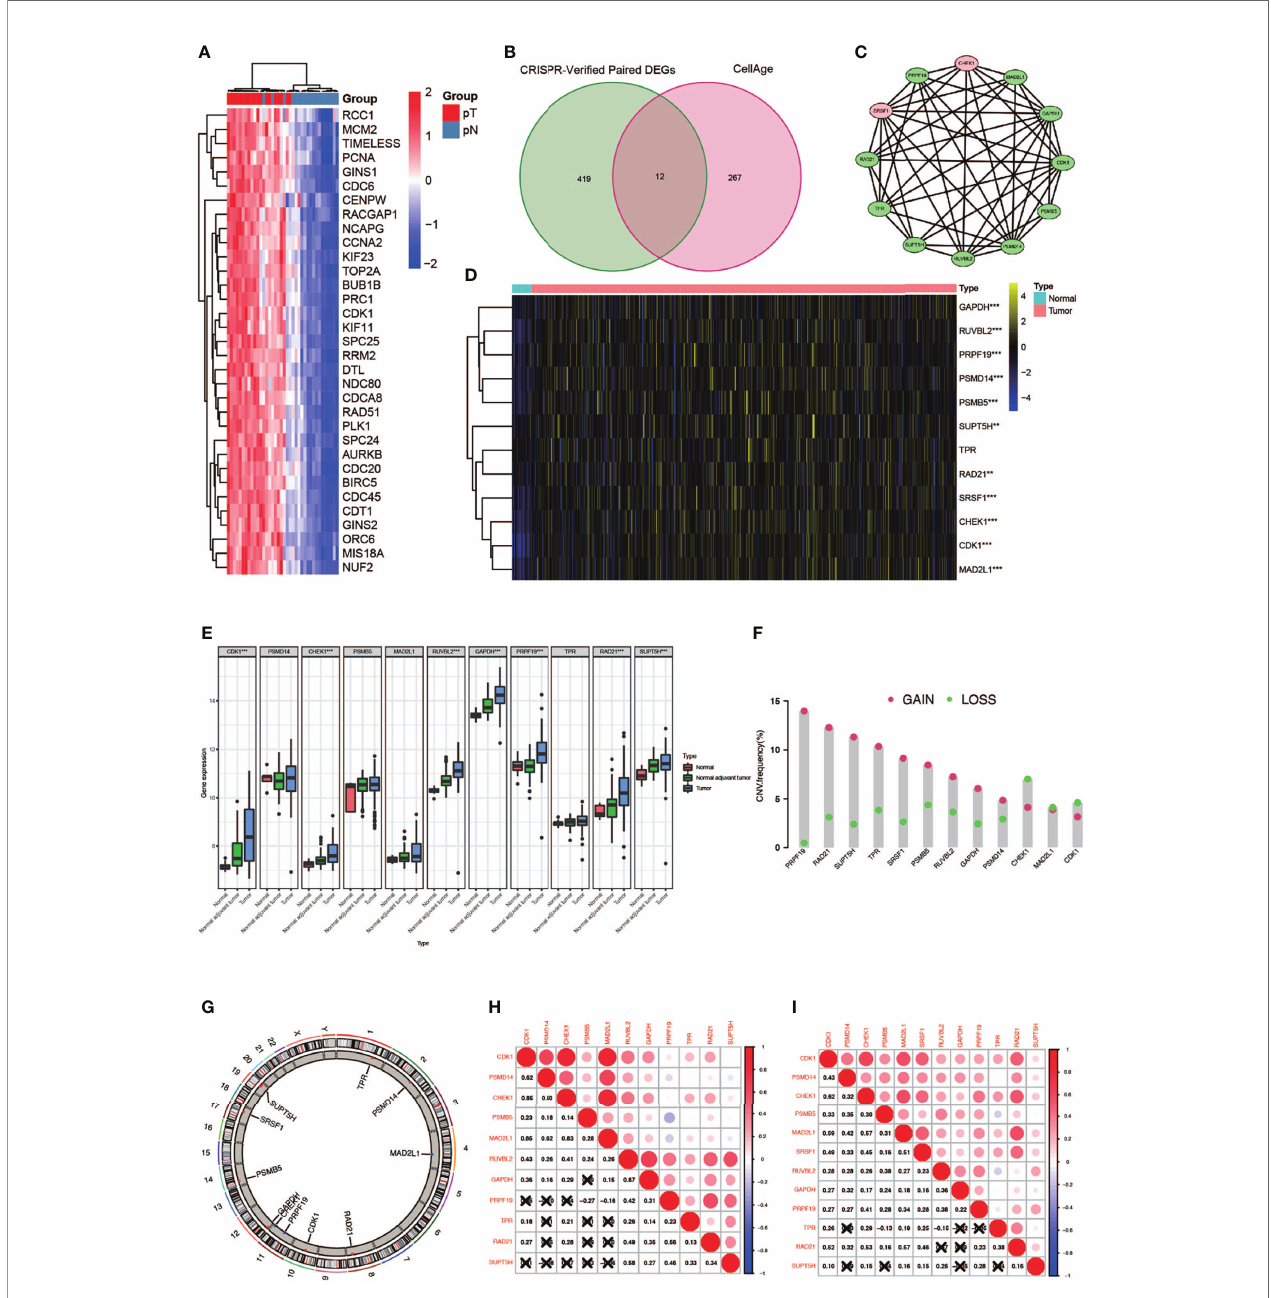
FIGURE 2 | Identi fi cation of 12 vital differentially expressed senescence genes in bladder cancer. (A) Genome-wide CRISPR veri fi ed paired differentially expressed gene (DEGS) in TCGA database. (B) Venn diagram of DEGs and senescence genes in the CellAge database. (C) Relationship among the 12 genes. (D) Twelve genes were differentially expressed in normal and tumor tissues (* P < 0.05; ** P < 0.01; *** P < 0.001). (E) Differentially expressed 12 genes in normal, normal adjuvant tumor, and tumor tissues (** P < 0.01; *** P < 0.001). (F) CVN diagram of 12 genes. (G) The location of these 12 genes on the chromosome. (H, I) Correlation between 12 genes in TCGA (left) and GEO (right)